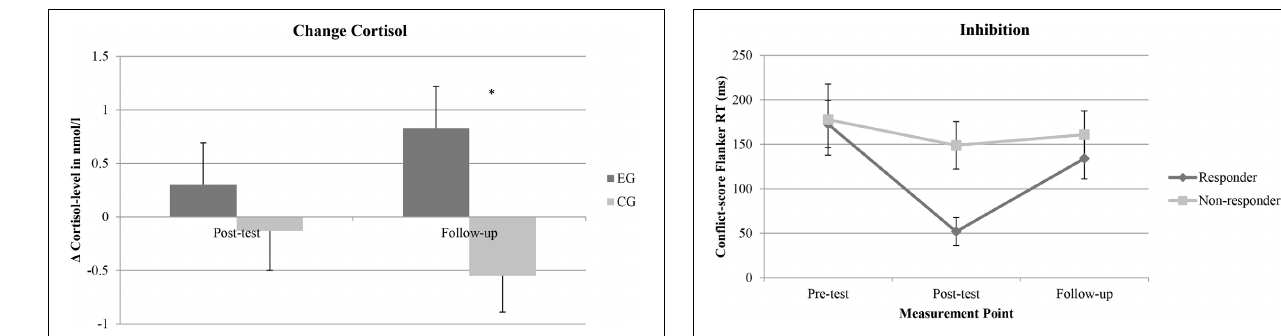
FIGURE 3 | Representation of means and error bars (representing standard error of the mean) for the (cid:2) in Cortisol level in nmol/l compared to pre-test. EG , experimental group, CG , control group. ∗ p < 0 . 05. or when controlling for inhibition performance at pre-test or at post-test, respectively.